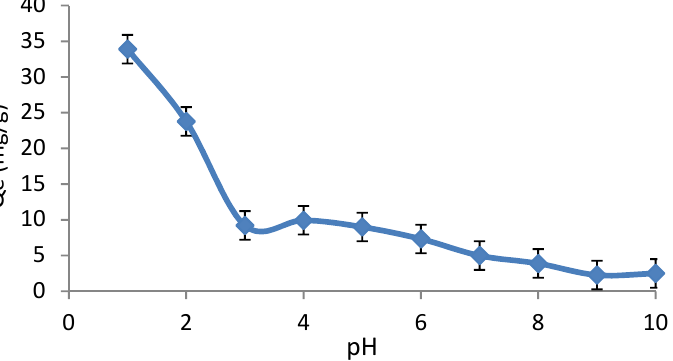
Figure 2. Effect of pH on the adsorption of MR onto D. viscosa plant bark.